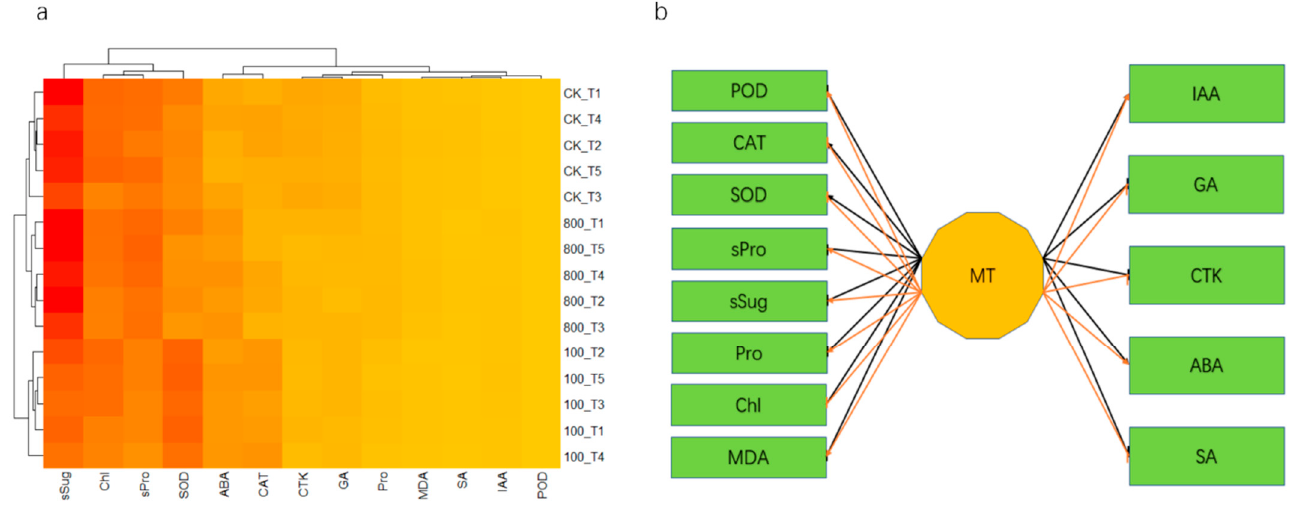
Figure 8. ( a ) Heatmap of physiological indexes of Populus cathayana × canadansis ‘Xin lin 1’ under 100 µ M and 800 µ M for different time periods. T1 means 10 days, T2 means 14 days, T3 means 18 days, T4 means 22 days, T5 means 26 days. ( b ) Effects of different doses of MT on various physiological indexes. Arrows indicate facilitation, flat arrows indicate inhibition. Black for 100 µ M; red for 800 µ M; POD, peroxidase; Chl, chlorophyll; Pro, proline; sSUG, soluble sugar; sPRO, soluble protein; MDA, malondialdehyde; SOD, superoxide dismutase; CAT, catalase; IAA, auxin; CTK, cytokinin; GA, gibberellin; ABA, abscisic acid; SA, salicylic